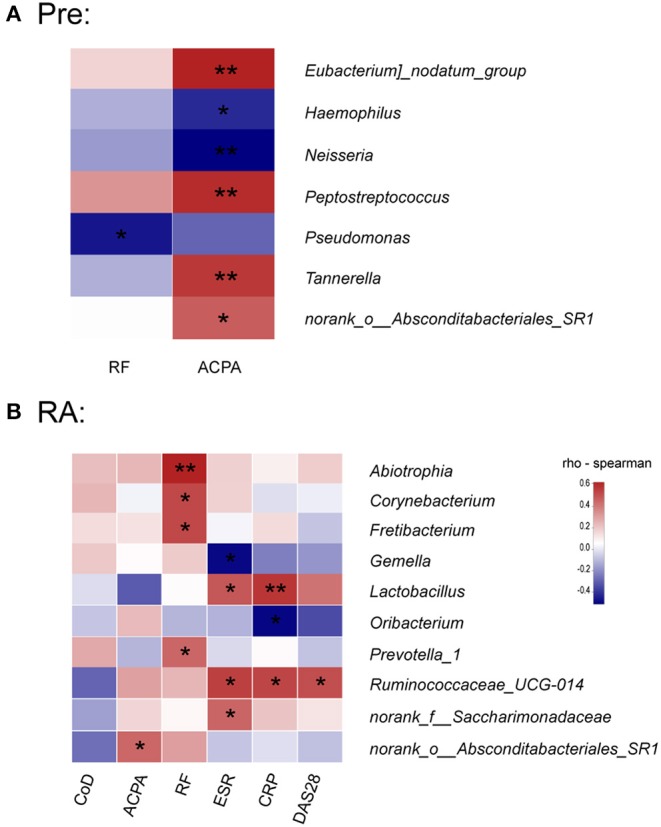
Association between saliva microbiota abundance and systemic autoimmune signature in high-risk individuals and RA patients. (A,B) The correlations between the relative abundance of saliva bacterial genera with serum concentrations of ACPA and RF in high-risk individuals and RA patients. (B) Correlations between the relative abundance of specific genera and serum ACPA and RF concentrations, disease activity score (DAS28), serum acute phase reactants levels, and course of the disease (CoD) in RA patients. The color scale represents the magnitude of correlation. Red scale indicates positive correlations; blue scale indicates negative correlations. Pre, “pre-clinical” at risk for RA individuals; RF, rheumatoid factor; ACPA, anti-citrullinated protein antibodies; CRP, C-reactive protein; ESR, erythrocyte sedimentation rate. *p < 0.05 and **p < 0.01.